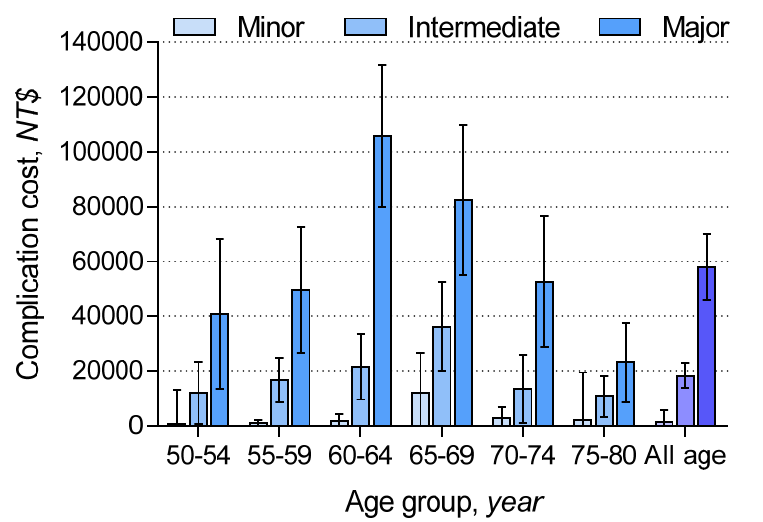
Figure 2. Incremental one-month complication costs (95% confidence intervals) by the severity of complications, stratified by age group. NT$30 = US$1.